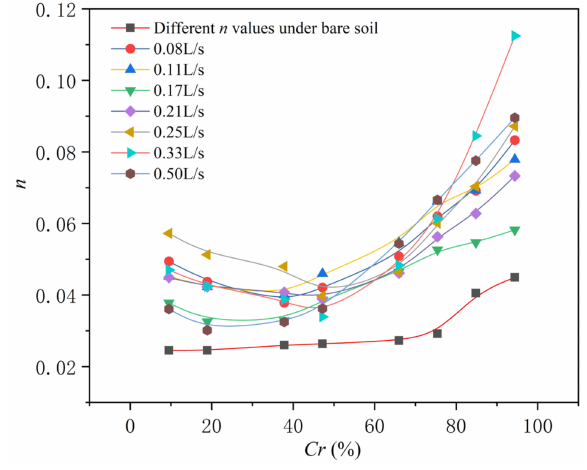
Figure 7. Relationship between vegetation coverage ( Cr ) and roughness coefficient ( n ).